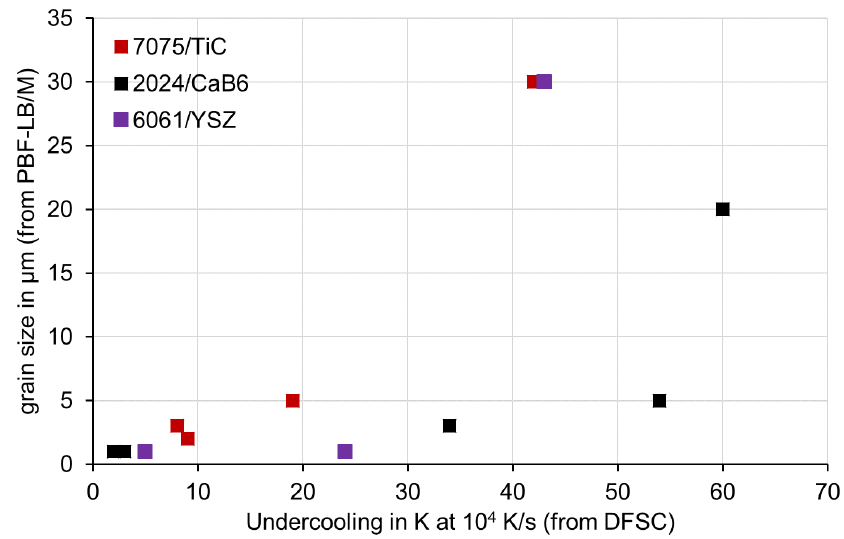
Figure 5. Correlation between grain size and solidification undercooling. Grain sizes of 2024/CaB 6 and 6061/YSZ have been adopted from [11,13].